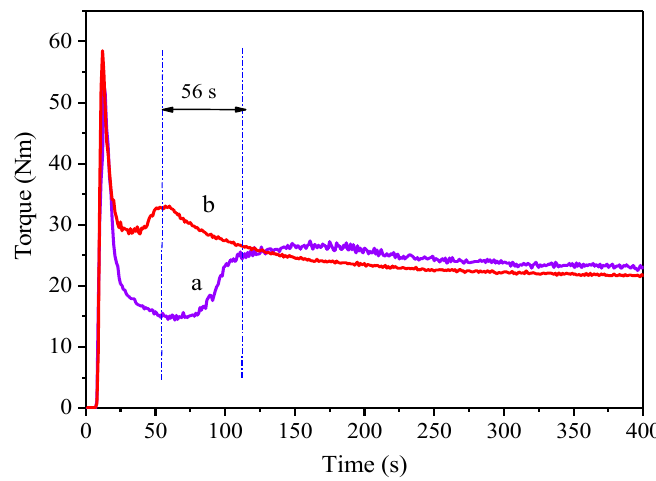
Figure 7. Torque rheology test results obtained at 180 °C on pure PVC ( a ) and PVC stabilized by DMAE-Zn ( b ).